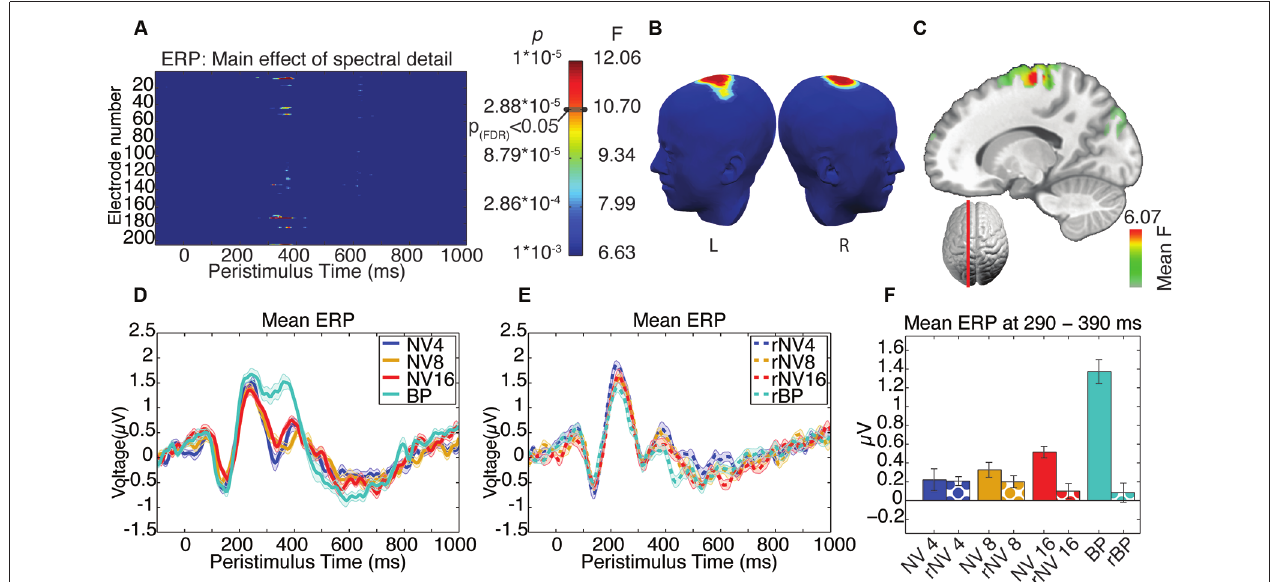
time-window of interest. (D) Average time-course of this effect in a cluster of five contributing electrodes across NV conditions. (E) Corresponding time-courses for the rotated conditions, where the effect of spectral detail is absent. (F) Mean evoked activity for each condition in the significant time-window, error bars represent standard error of the mean corrected to be appropriate for repeated-measures comparisons, as described in Loftus and Masson